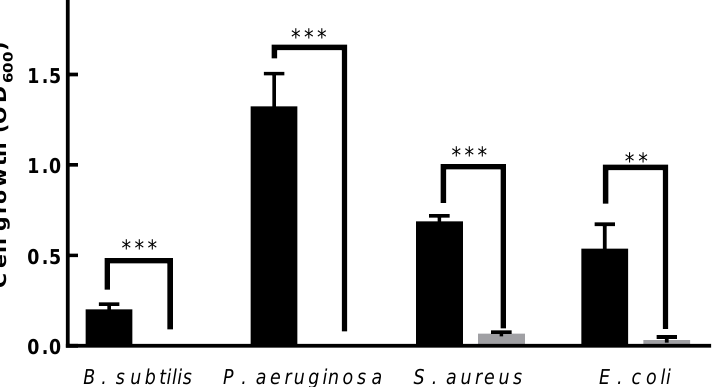
Figure 7. Antibacterial activity of L. paracasei EPS DA-BACS. The culture broth of indicator strains was inoculated in a 96-well plate at the final concentration of 1%( v / v ) and incubated at 37 ◦ C for 24 h. Black bar, the culture of indicator strains grown in MH medium; gray bar; L. paracasei EPS DA-BACS was added to the culture of indicator strains. Asterisks show significant differences among groups at **, p < 0.01; ***, p < 0.001 ( n ≥ 3) using one-way ANOVA and Dunnett’s test.